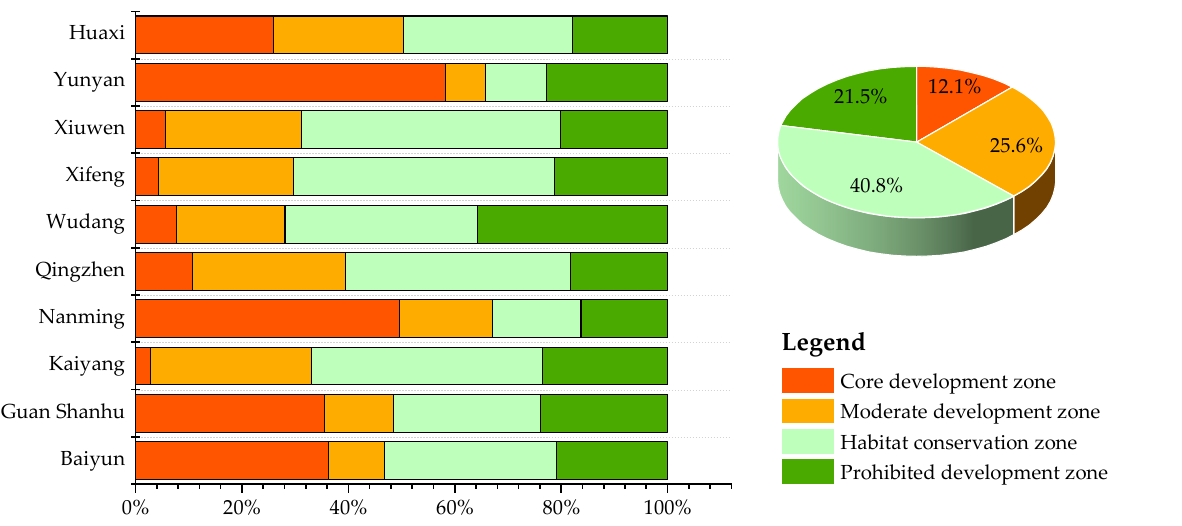
Figure 11. The proportion of different zones in the whole region and each county (district or